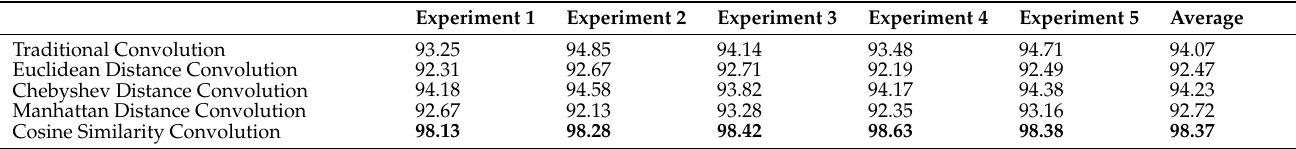
Table 2. Recognition accuracy (%) for different convolution methods.